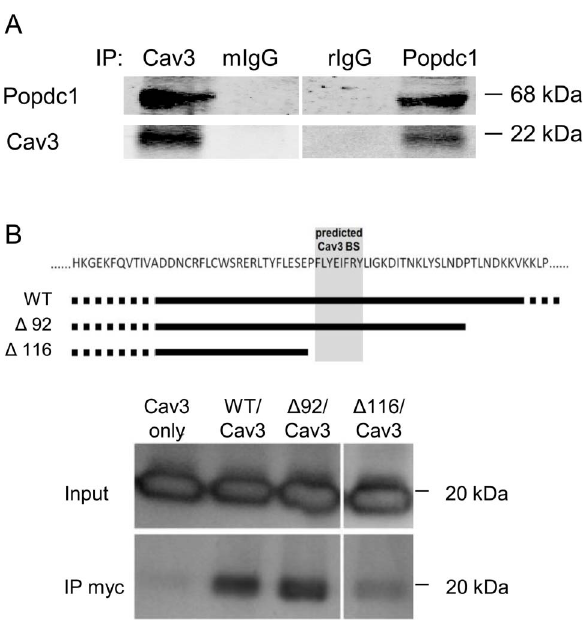
Figure 2. Co-immunoprecipitation of Popdc1 and Cav3. (a) Immunoblots demonstrating the precipitation of Popdc1 and Cav3 using mouse anti-Cav3 antibodies (left) and rabbit anti Popdc1 antibodies (right). Top labels: IP: immunoprecipitation tool; Cav3, anti- Cav3; mIgG, mouse immunoglobulins (control); Popdc1, anti-Popdc1 antibodies; rIgG, rabbit immunoglobulins (control). Left/right labels: Popdc1 migration at 68 kDa and Cav3 migration at 22 kDa. (b) Co- immunoprecipitation of Popdc1 and Cav3 from COS7 cells co- transfected with Cav3 and full length (WT) or deletion mutants ( D 92 and D 116) Myc-tagged Popdc1 expression constructs. The scheme depicts the position of the deletions relative to the predicted Cav3 binding site (BS). Shown is a Western immunoblot probed for the detection of Cav3. Input, Cav3 in the original cell extract; IP-Myc, Cav3 that was precipitated by the anti-Myc antibodies. The figure depicts results of a representative membrane.